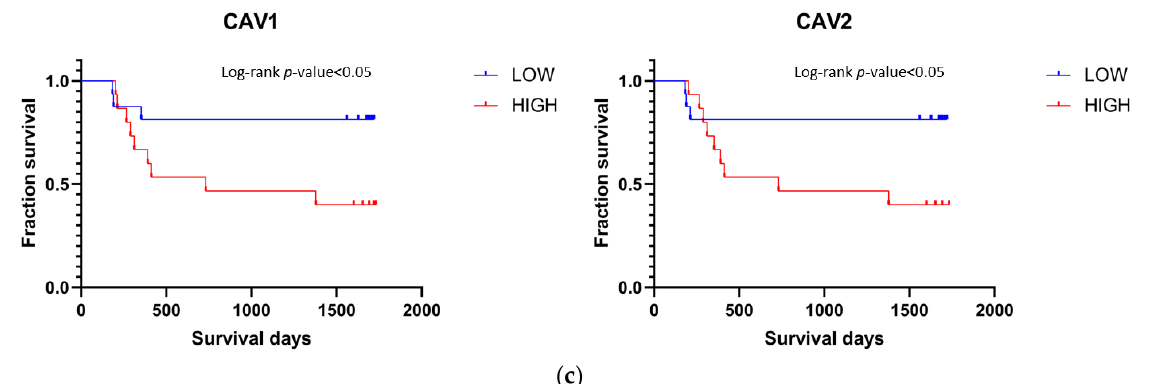
Figure 11. IHC analysis of cancer and paracancerous tissues in 172 patients confirms the CAV1 and CAV2 protein levels in HNSCC tissues, revealing that CAV1 and CAV2 are upregulated in HNSCC ( a ). The result shows a significant correlation is found for H-score in HNSCC and in OM cases after comparing the H-score, which represents the expression levels of target genes ( p < 0.0001) (( b ); mean ± SD: 6.21 ± 0.07; mean ± SD: 54.89 ± 2.36; mean ± SD: 9.72 ± 0.07; mean ± SD: 90.64 ± 95.81). Survival analysis shows a significant correlation between the low expression levels of CAV1 and CAV2 and longer survival days, indicating better prognostic performance ( c ).